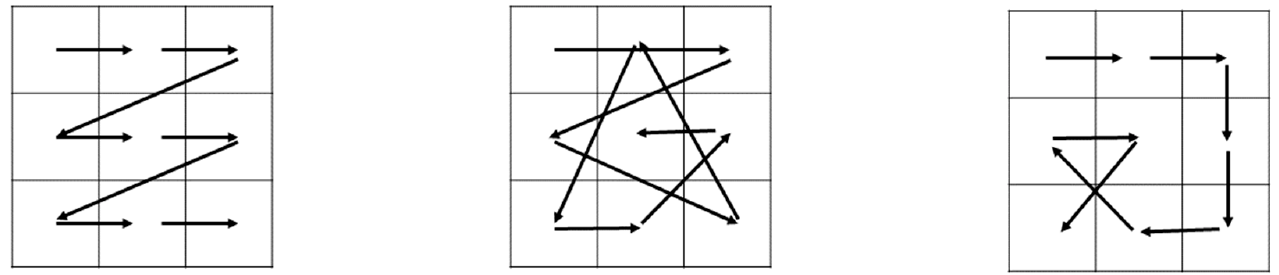
Figure 5. Grid search ( left ), random search ( middle ), and Bayesian search ( right ).